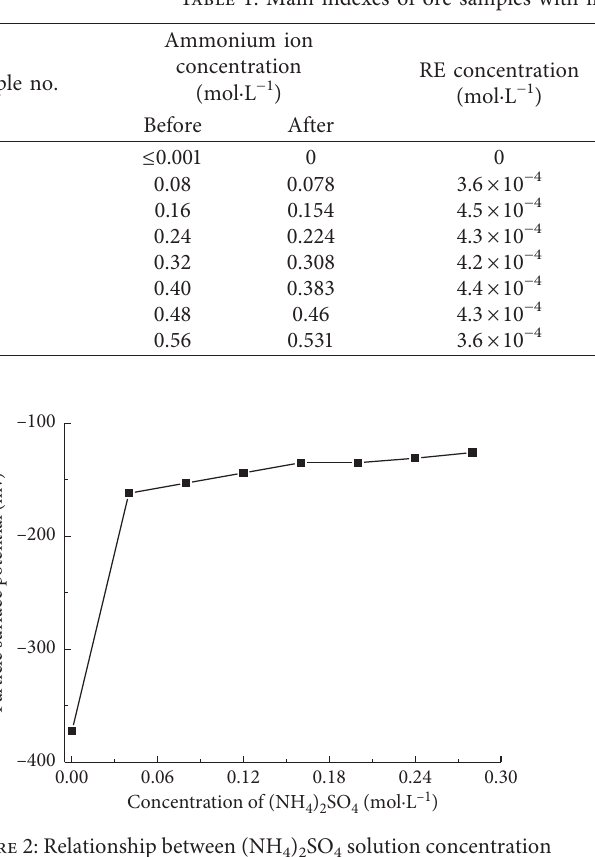
4 ) 2 SO 4 solution concentration